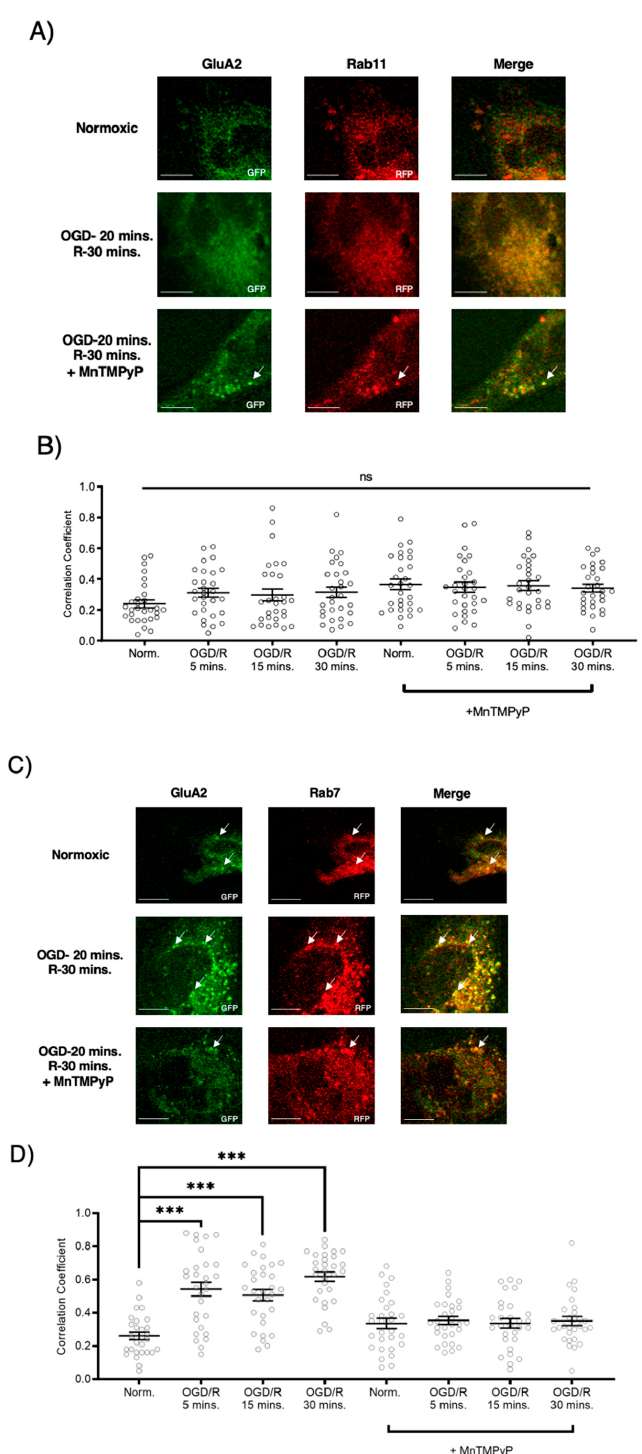
Figure 6. MnTMPyP prevented OGD/R-induced Rab-7, late endosomal sorting of GluA2 AMPAR subunits. GluA2 was not present in Rab11, recycling endosomes under any conditions. U-251 MG cells transfected with GluA2-eGFP, and either Rab11-RFP, a recycling endosome marker, or Rab7-RFP, a marker for late endosomes, and exposed to either normoxic or OGD/R conditions. ( A ) GluA2 did not colocalize with Rab11 under normoxic nor OGD/R conditions. ( B ) Quantification of microscopy (n = 30) results from ( A ). ( C ) Increased colocalization between GluA2 and Rab7, indicating lysosomal degradation, maximally at OGD/R-30 min; the effect was ameliorated with pretreatment of MnTMPyP. D) Quantification of microscopy (n = 30) results from ( C ). *** p < 0.001; ANOVA with Tukey’s post hoc test comparing OGD/R conditions to corresponding control (normoxic ± MnTMPyP). Data are expressed as mean ± SEM. Scale bar is 100 µ M. Arrows indicate